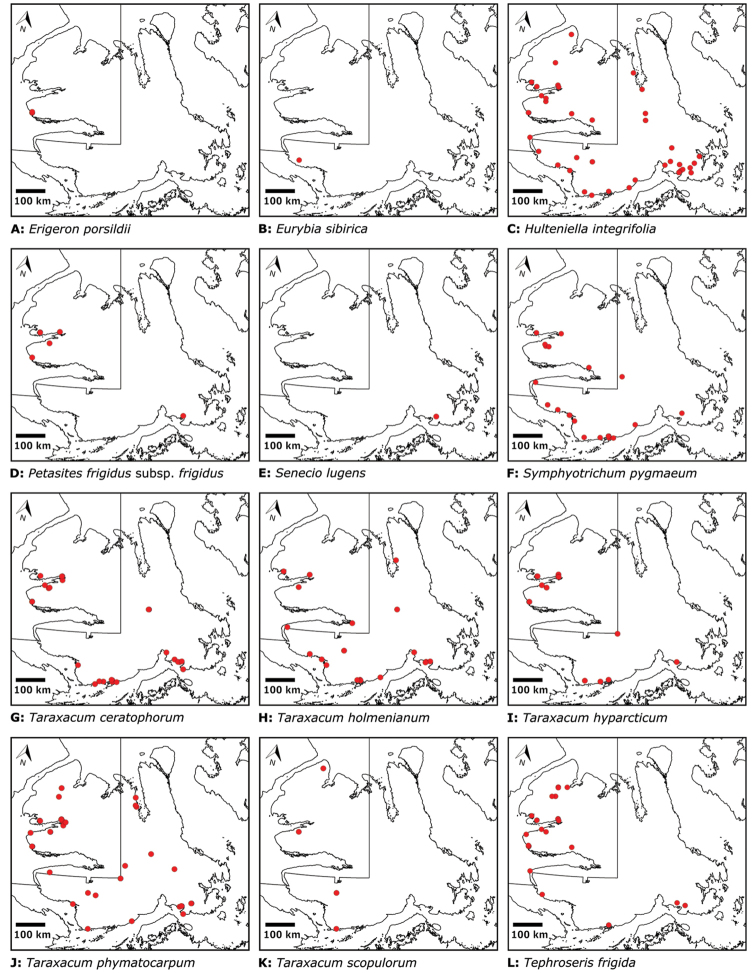
Species distribution maps. Asteraceae: AErigeron
porsildiiBEurybia
sibiricaCHulteniella
integrifoliaDPetasites
frigidus
subsp.
frigidusESenecio
lugensFSymphyotrichum
pygmaeumGTaraxacum
ceratophorumHTaraxacum
holmenianumITaraxacum
hyparcticumJTaraxacum
phymatocarpumKTaraxacum
scopulorumLTephroseris
frigida.